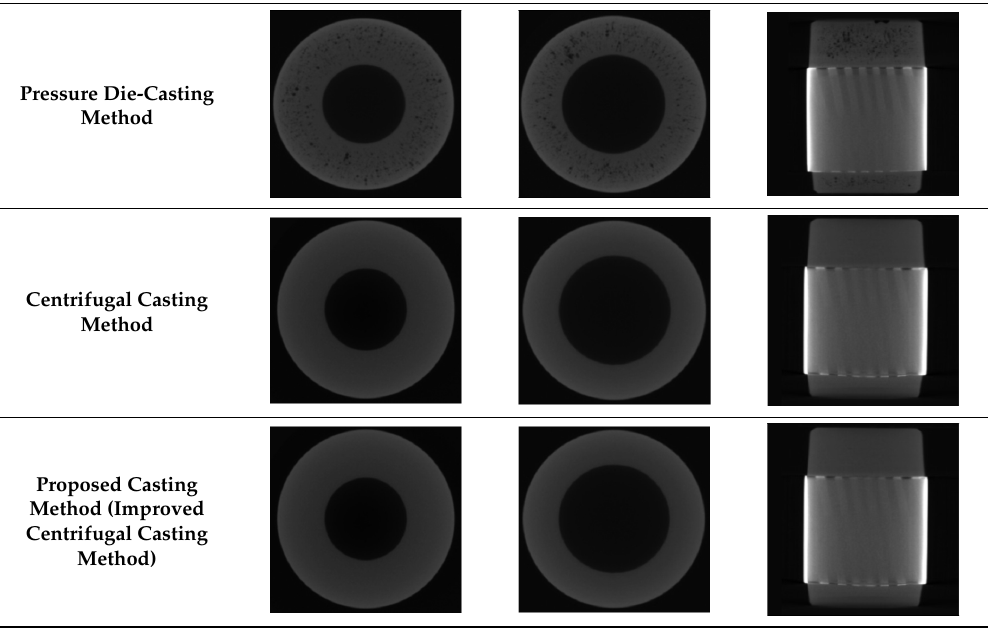
Table 2. The tomogram of the inside of each type of rotor, taken using an X ‐ ray scan.